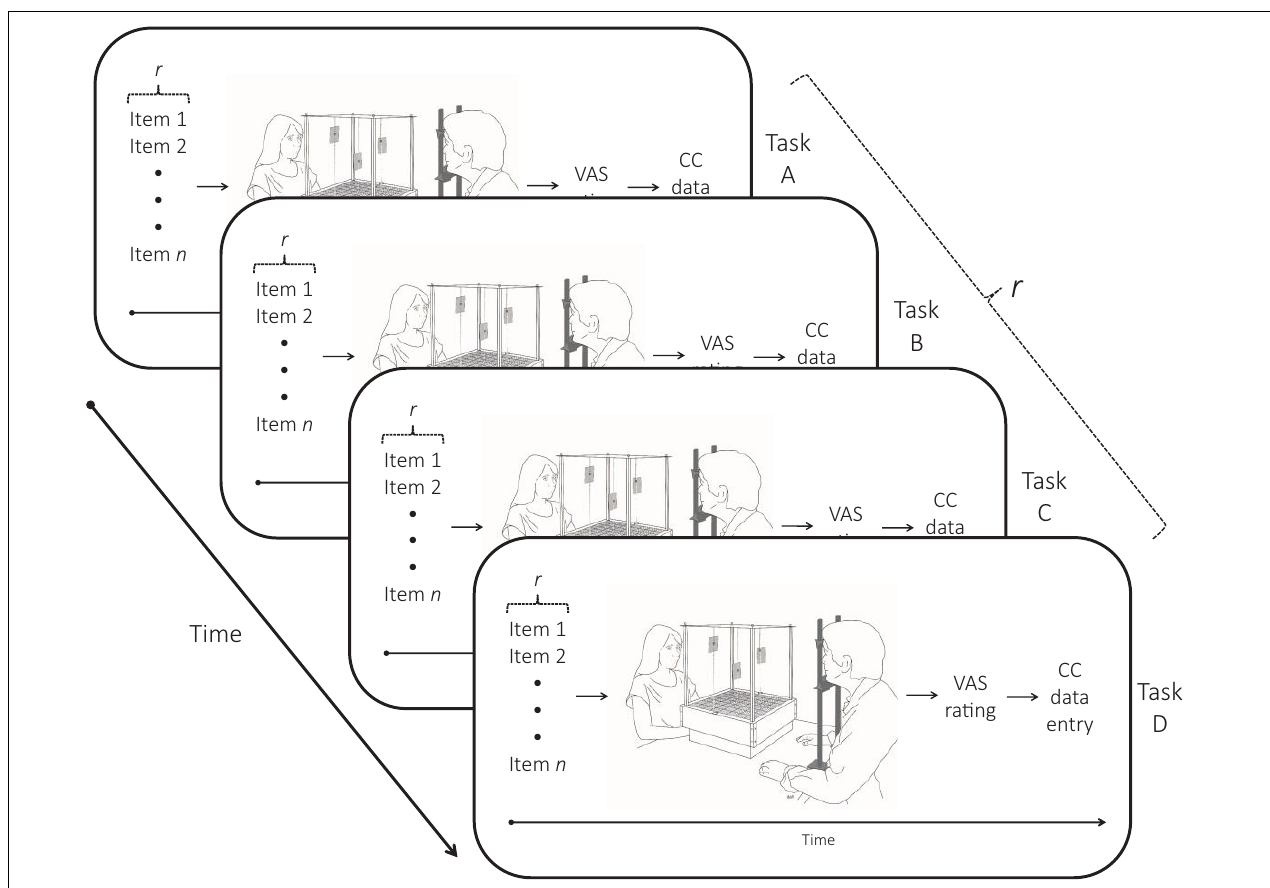
FIGURE 1 | Illustration of the experimental sequence. Presentation of the four modalities (visual, auditory, tactile, olfactory) was counterbalanced, and the respective modality items (images, sounds, smells, textures for Tasks A ∼ D) were randomly presented in each modality set ( r ). The following fixed sequence of events occurred within each task: (i) stimuli were presented one by one (item 1 ... n ); (ii) stimuli were allocated spatially within the cognition cube (CC); (iii) stimuli were rated (VAS rating); and (iv) the X , Y , and Z coordinates of each stimulus were measured and recorded.